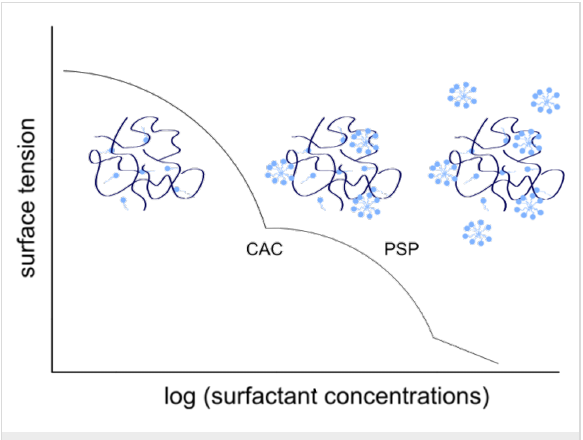
Figure 6: Scheme of possible interactions of PEI–Triton X-100.